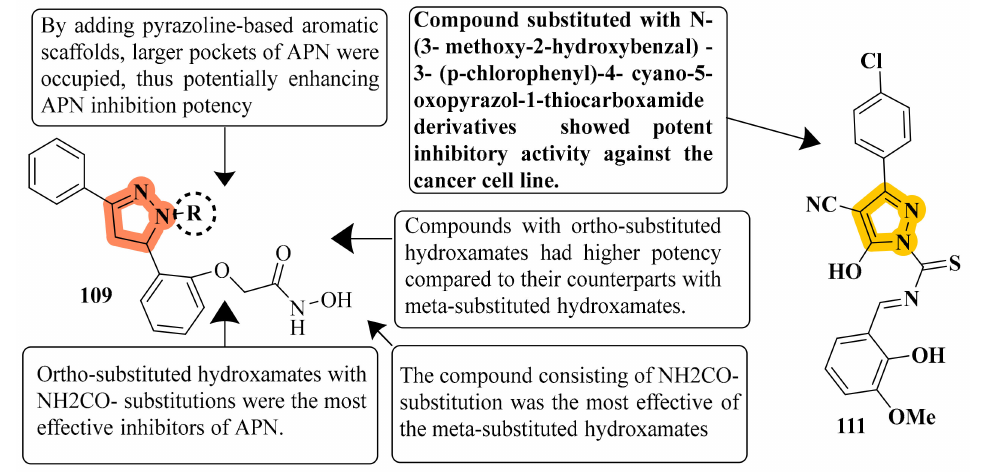
Figure 6. Structure and SAR of potent anticancer activity compounds 109 and 111